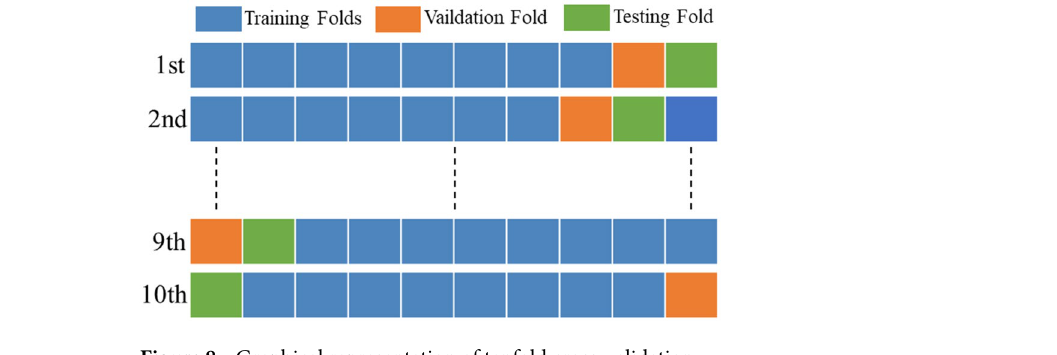
Figure 8. Graphical representation of tenfold